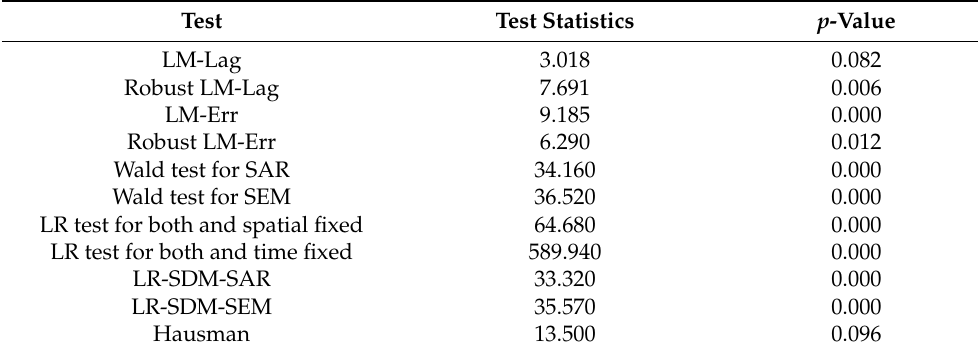
Figure 6. LISA cluster map of ULGUE in the YRB from 2004 to 2017. ( a – n ) correspond to the years 2004 to 2017, respectively. Table 4. Test results of spatial panel model